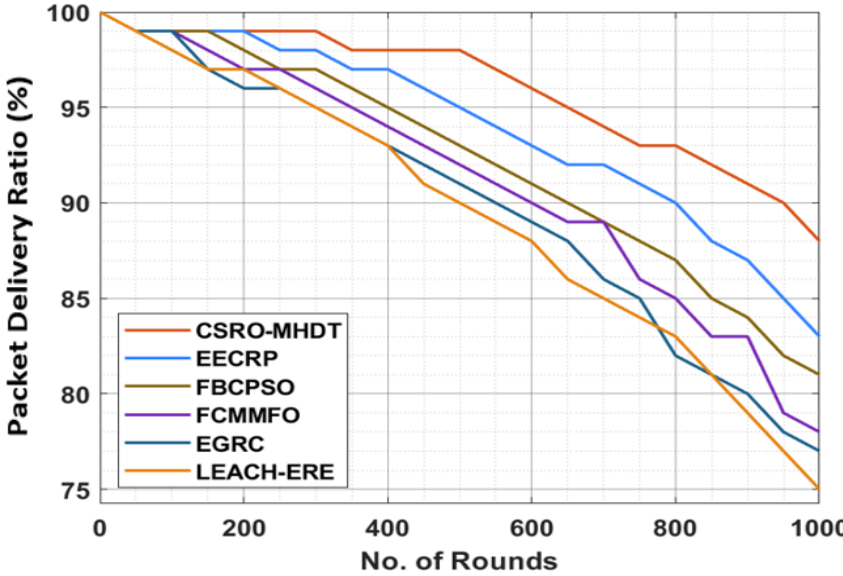
Figure 8. PDR analysis of the CSRO-MHDT technique in comparison with existing approaches.